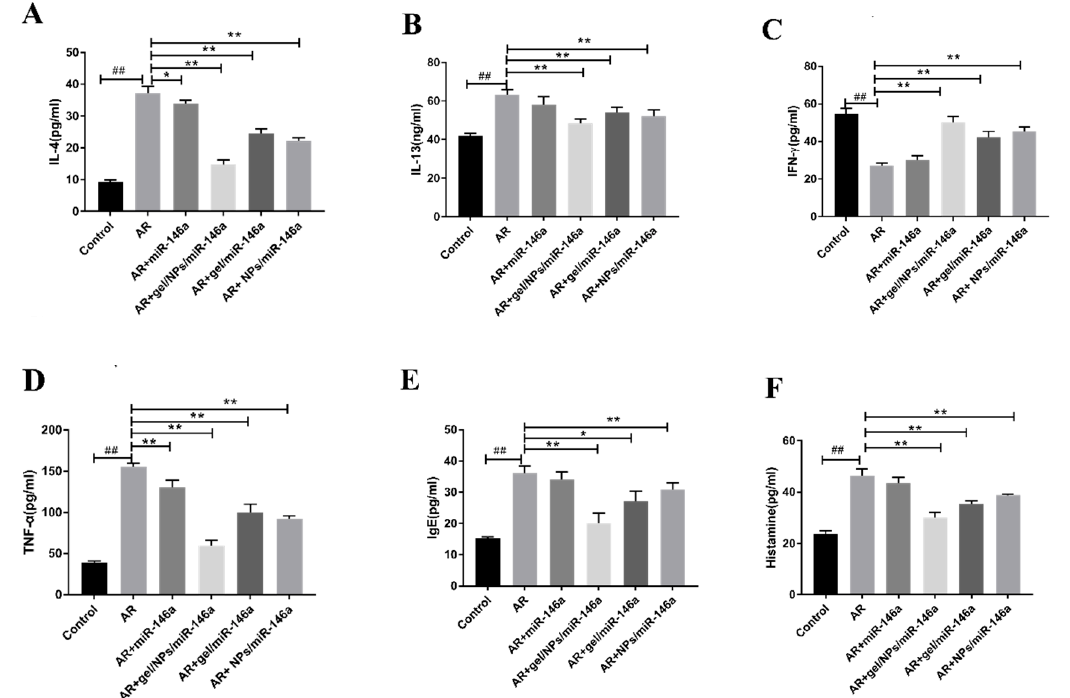
Figure 5. The e ff ects of miR-146a delivered by binary formulations on cytokines in AR rat serum. The contents of ( A ) IL-4, ( B ) IL-13, ( C ) IFN- γ , ( D ) TNF- α , ( E ) IgE and ( F ) histamine in rat serum were determined by ELISA. Data represent the mean ± SD of three independent experiments. ## p < 0.01 compared with the control group; * p < 0.05, ** p < 0.01 compared with the AR group.